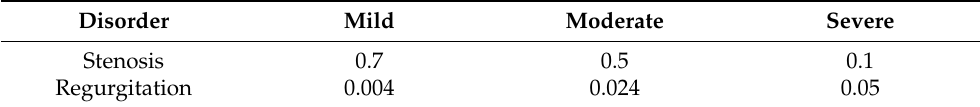
Table 4. Mitral and aortic valve pathology values. The different values provided in the table are applied to U mi and U ao to simulate different severities of valve pathologies. Refer to Section 2.4 for an explanation of how this is done. For stenosis, 0.7, 0.5, and 0.1 represent 30, 50, and 90% flow restriction. For regurgitation, the values are identical to [16] who use the clinical definition of regurgitation severity.